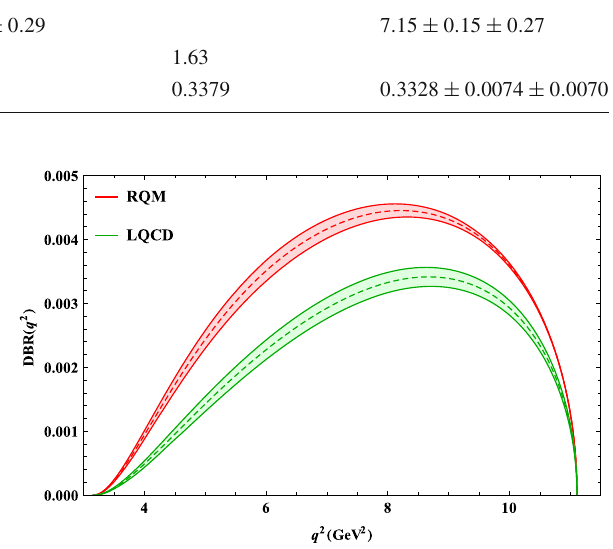
Fig. 1 Comparison of the differential branching fraction for Λ b → Λ τ − ¯ ν τ decay in the SM obtained using RQM framework (red) and c lattice calculations